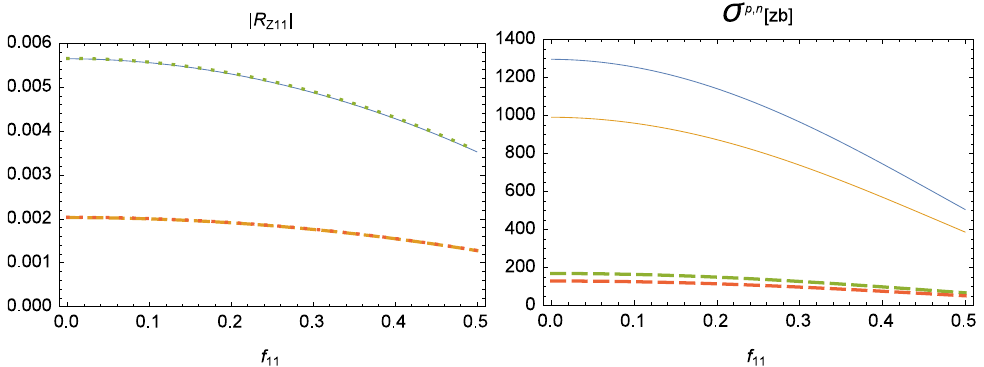
Figure 3. ( Left ) The coupling | R Z 11 | and ( Right ) the cross-section σ p , n as a function of f 11 for ˜ f = − 0.41, tan β = 2, (cid:101) µ = 2TeV, µ = 200GeV (solid lines) and µ = 1TeV (dashed lines). 11 1 11 11 The upper solid and upper dashed lines represent σ p while lower solid and lower dashed lines are associated with σ n . The dotted lines correspond to the approximate expression for R Z 11